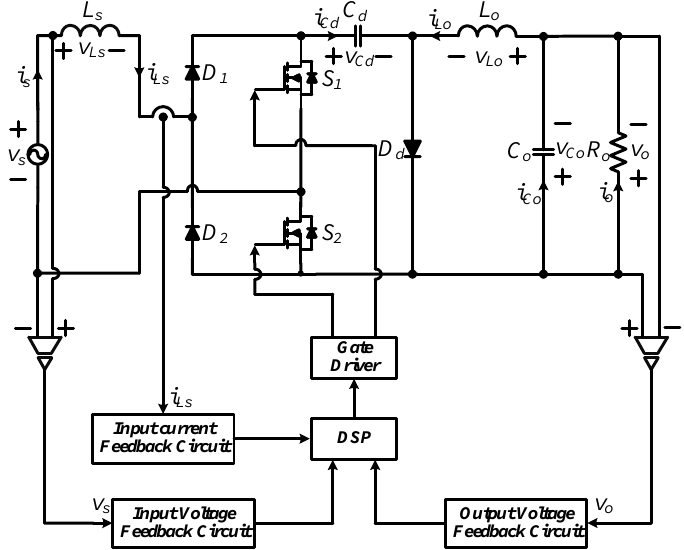
Figure 21. Experimental hardware construction block diagram.